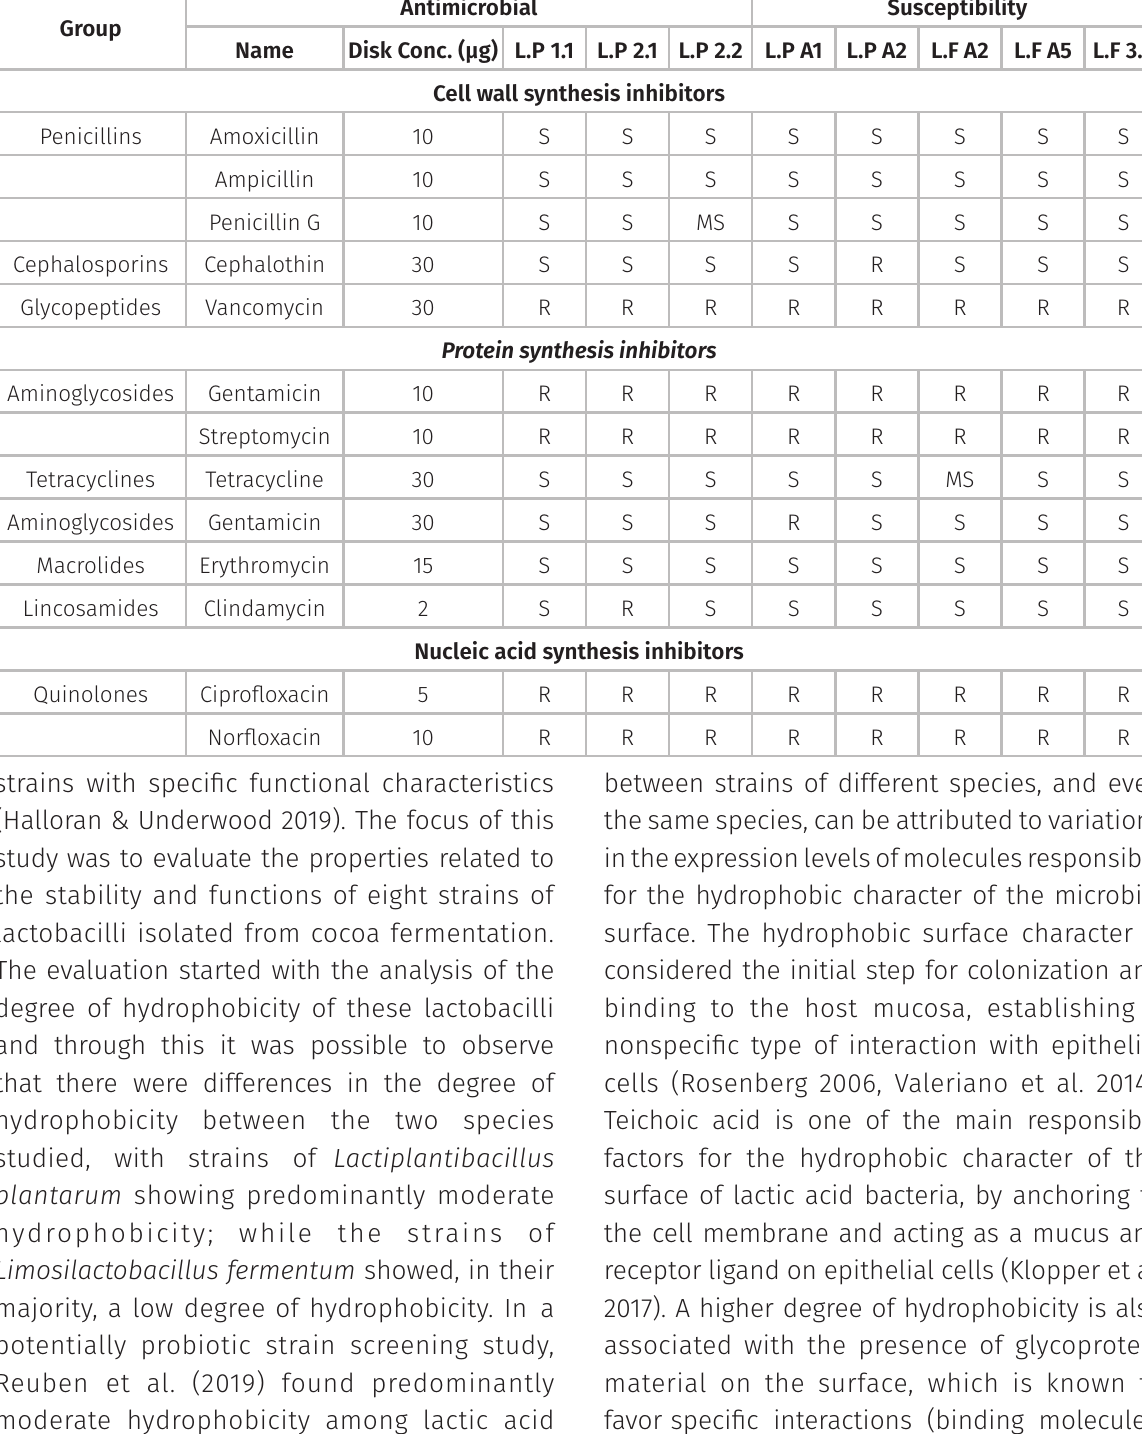
Table II. Susceptibility profile of 8 strains of Lactobacillus isolated from cocoa fermentation.